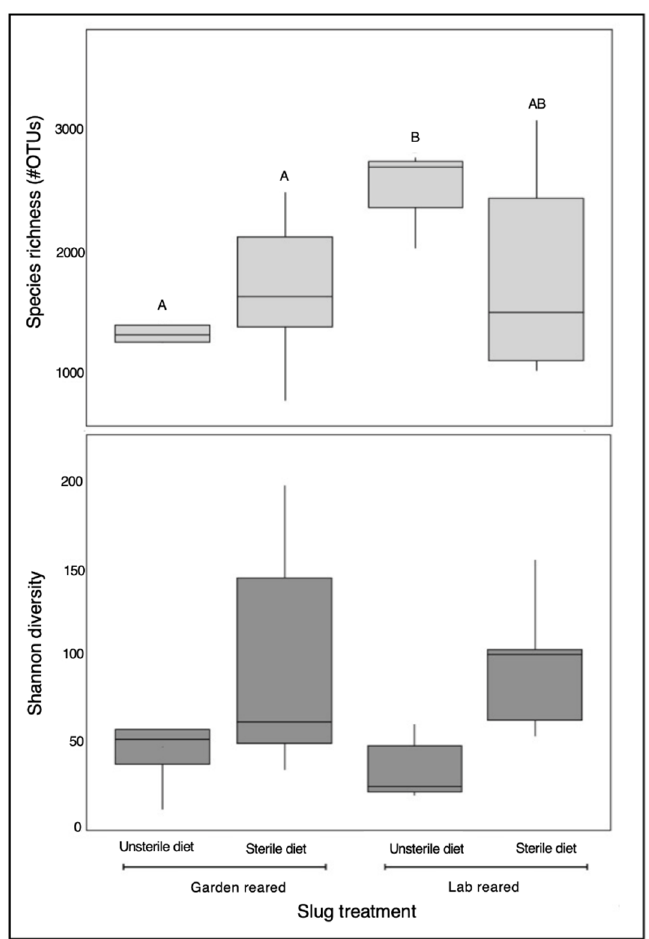
Figure 3. Box plot representation of species richness and Shannon diversity among treatment groups, compared using Wilcoxon tests. Treatments with individual A or B letters are significantly different from one another across treatment groups ( p < 0.05). Treatments sharing A or B letters are not significantly different from on another across treatment groups. Lab-reared slugs fed an unsterile diet harbored significantly more bacterial taxa in their microbiome than garden-reared slugs. Shannon diversity values were equivalent across all treatment groups. Garden Unsterile N = 4, Garden Sterile N = 14, Lab Unsterile N = 4, Lab Sterile N = 5.